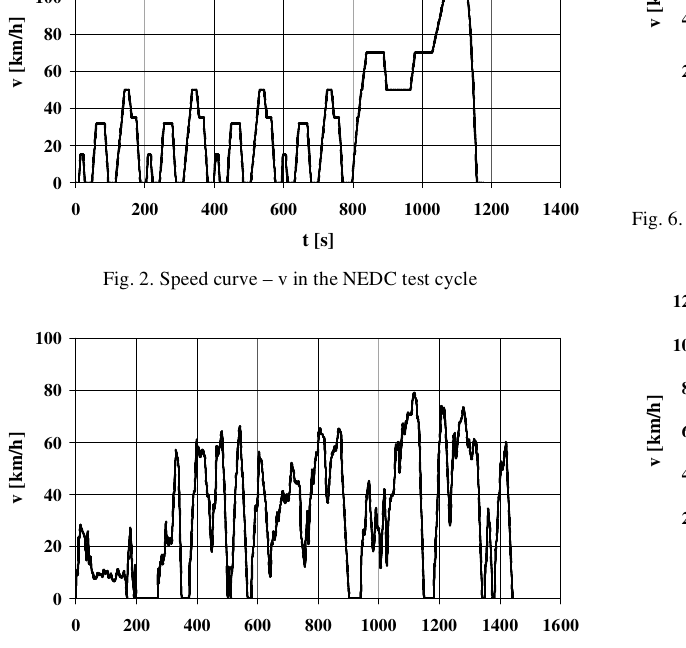
Fig. 7. Speed curve – v in the RDE test cycle performed with a Fiat Idea – drive cycle fragment of the highway drive section –